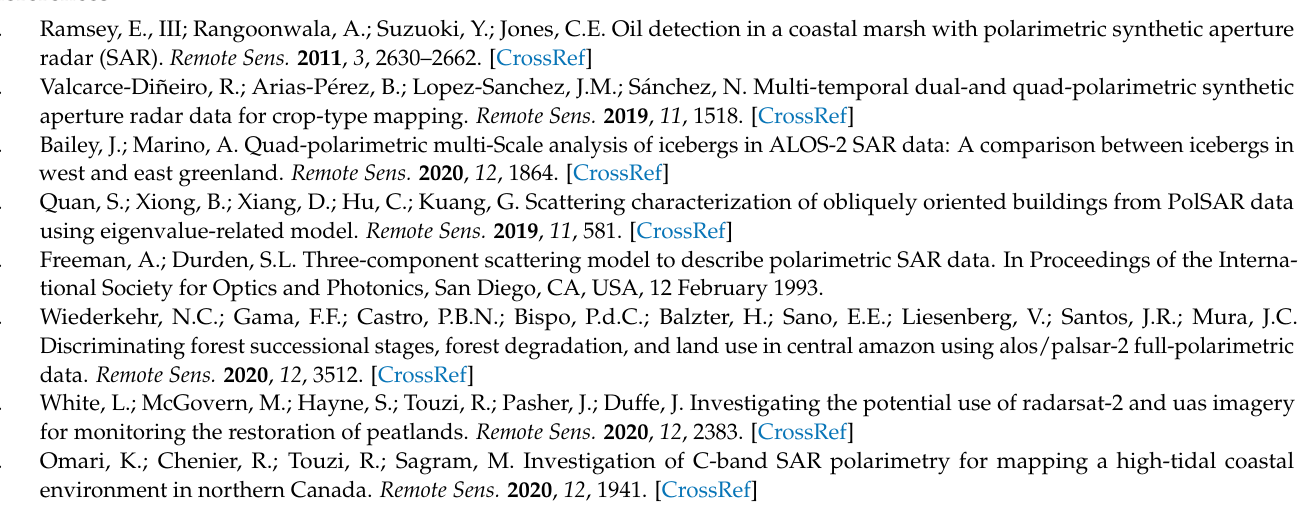
scattering power Pd estimated by ADAM, FDD and 7CD for 8 types of samples over Wuhan, China; Figure S4: The output map of volume scattering power Pv estimated by ADAM, FDD and 7CD for 8 types of samples over Wuhan, China; Table S1: The statistical results of the aggregation parameter γ for 8 types of samples over Wuhan, China; Table S2: The statistical results of the Ps in 8 types of samples over Wuhan, China; Table S3: The statistical results of the Pd in 8 types of samples